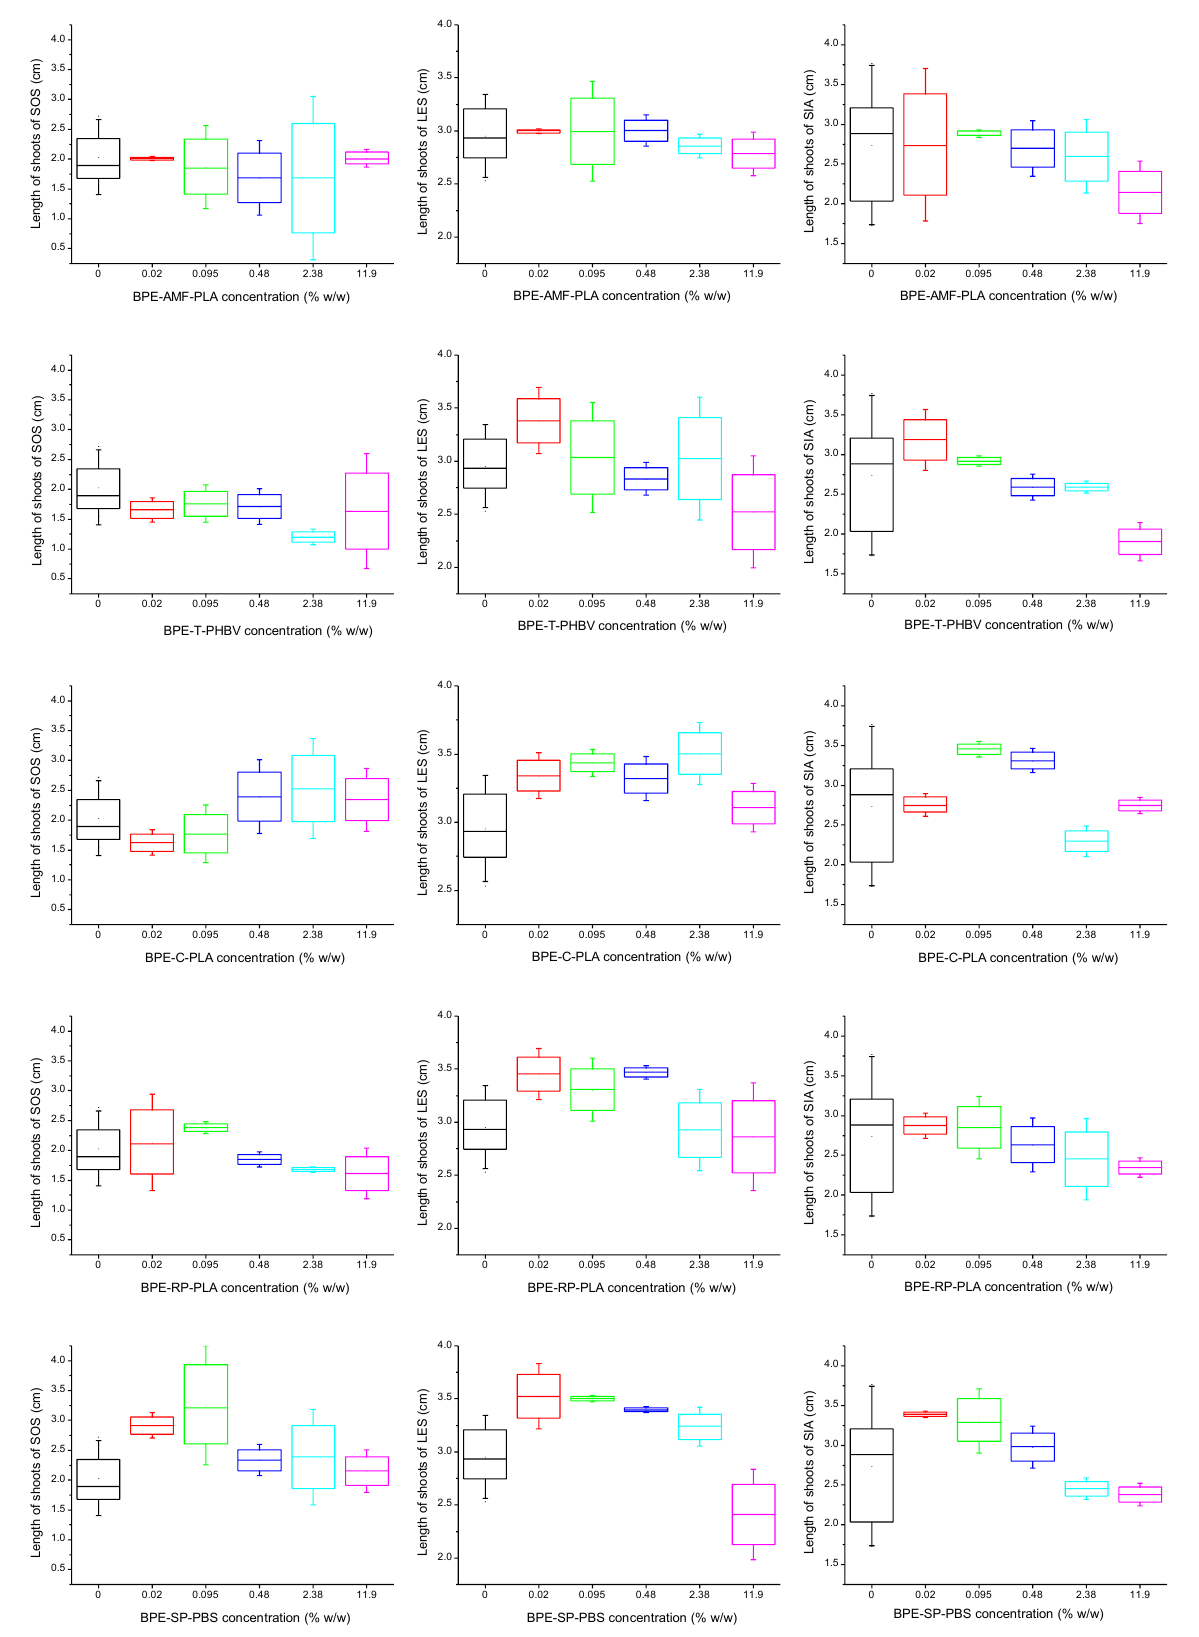
Figure 3. Effect of bio-based plastics on shoot growth of higher plants: Sorghum saccharatum (SOS), Lepidium sativum (LES) and Sinapsis alba (SIA).